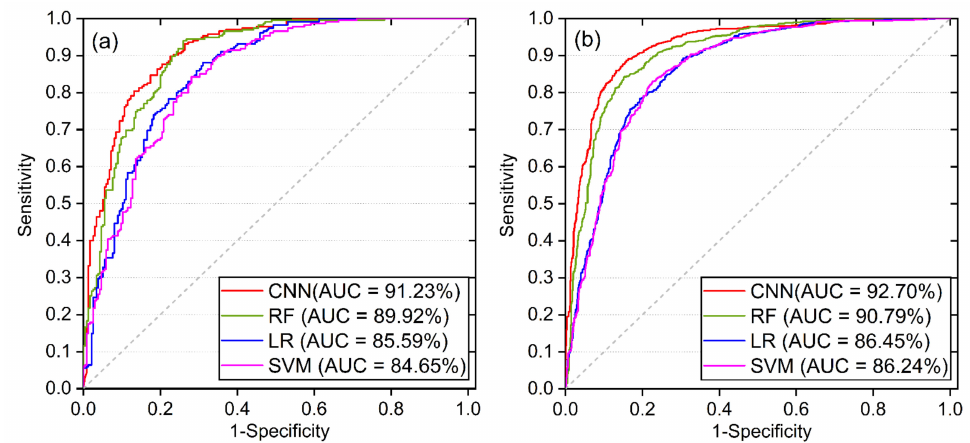
Figure 8. The feature extraction process of the CNN-based landslide susceptibility model of Zhangzha Town.